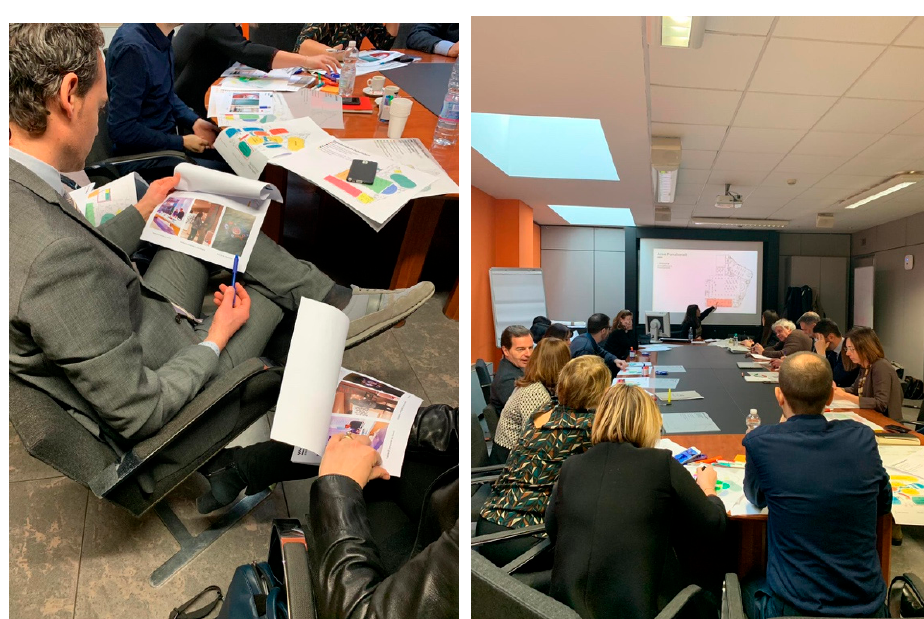
Figure 4. Co-design activities tools.